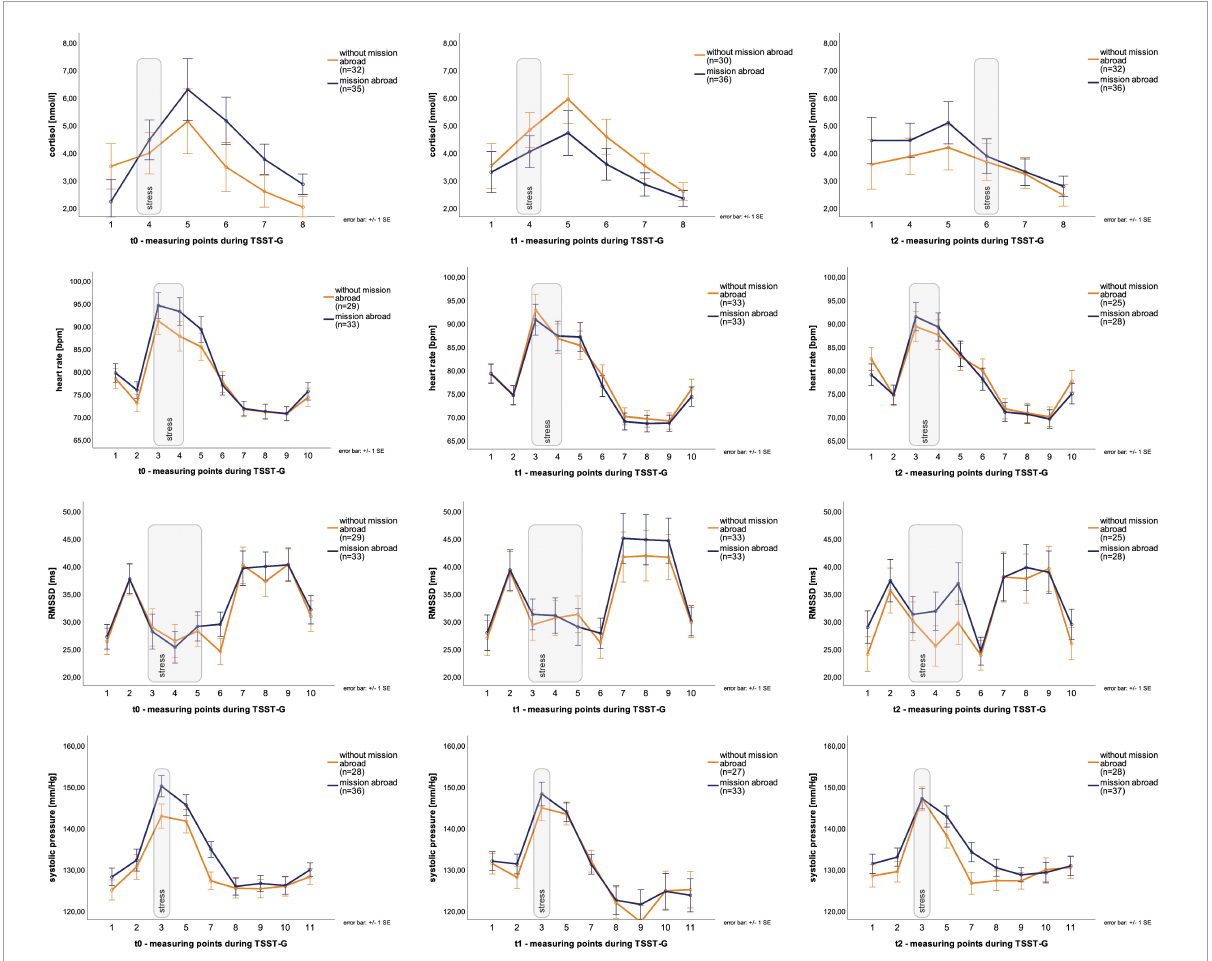
FIGURE2 Stress response within Trier Social Stress Test for groups (TSST-G) (t0, t1, t2). Y-axis values: absolute values for cortisol (nmol/l), heart rate (bpm), RMSSD (ms), systolic pressure (mm/Hg). Stress: induced stress exposure following TSST-G protocol; width of stress bars reflects the number of measurement points within the variable; values are means ( ±